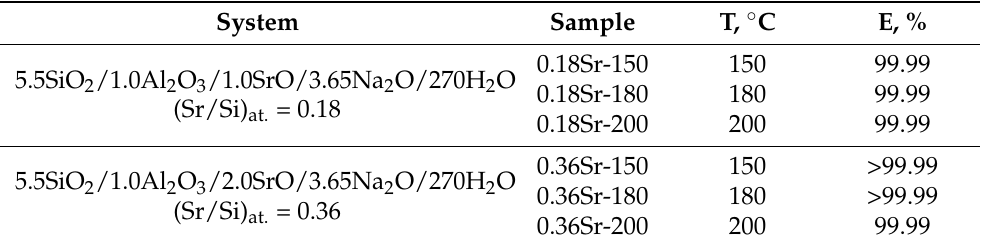
Table 1. Molar composition of reaction mixtures and efficacy of the Sr 2+ trapping from reaction